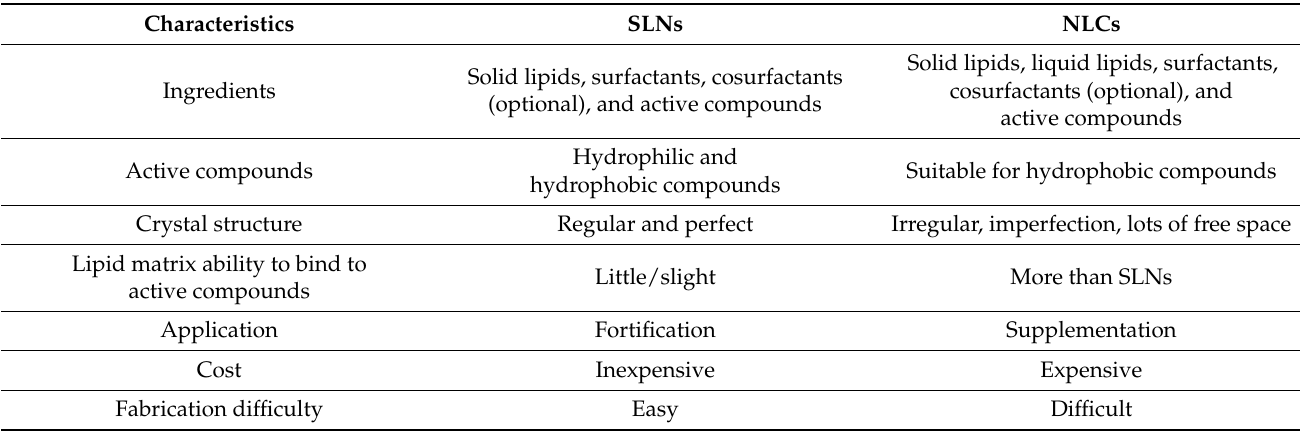
Table 1. The differences between SLNs and